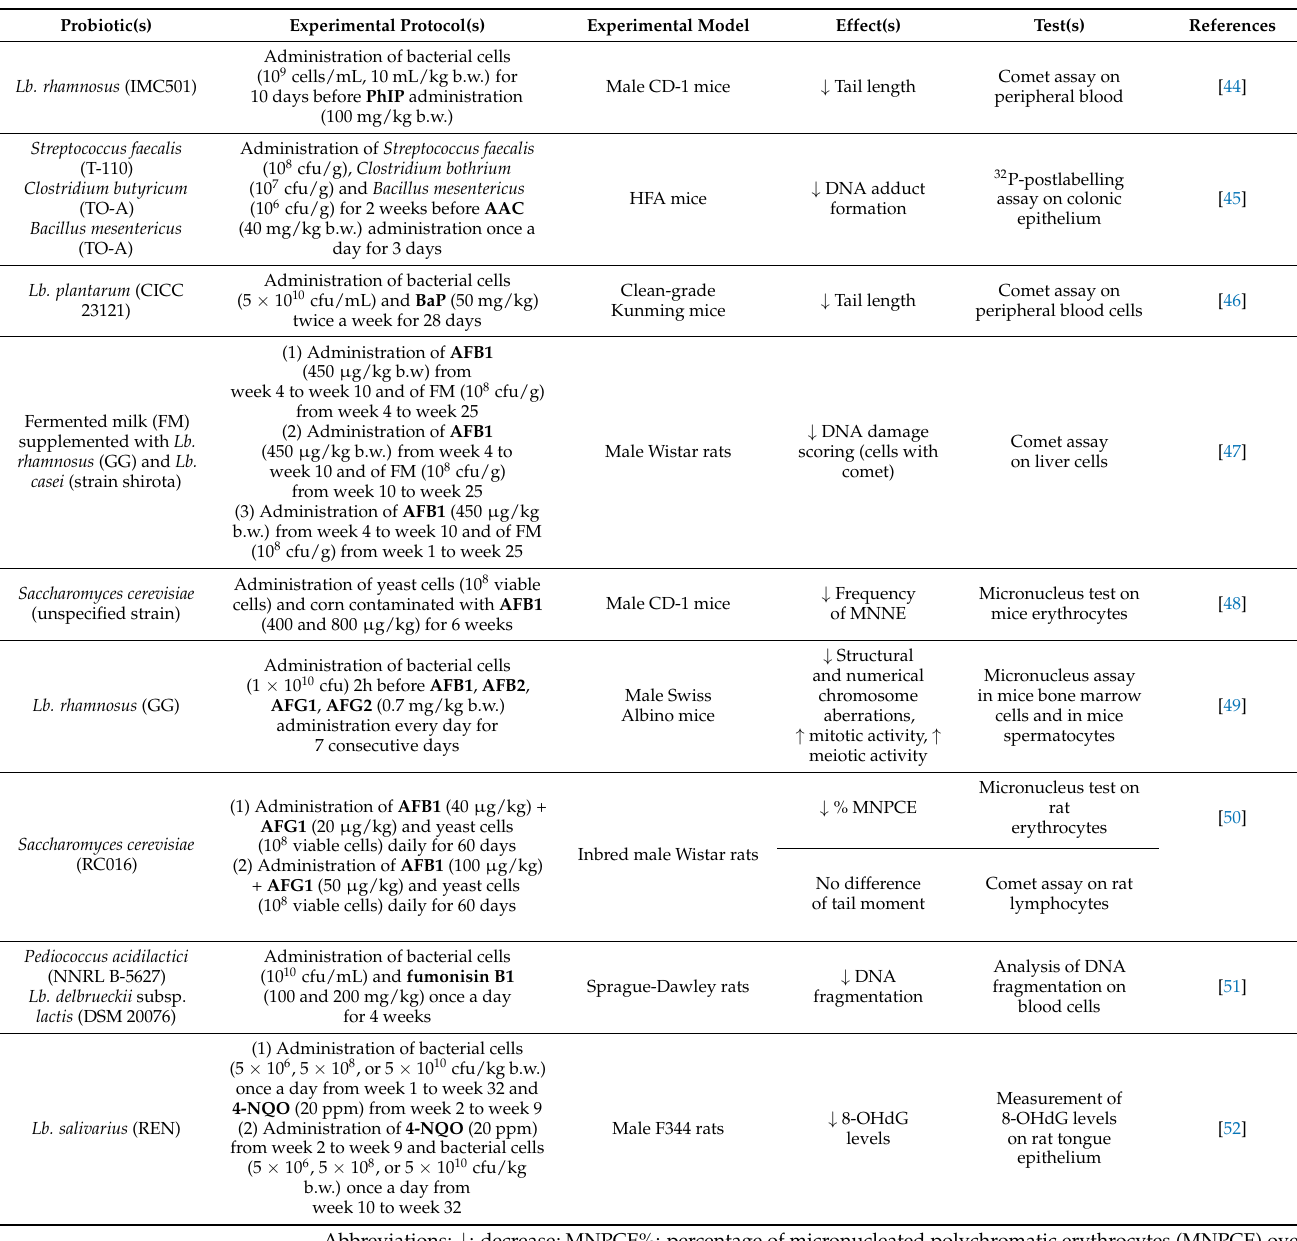
Table 2. In vivo antigenotoxic activity of